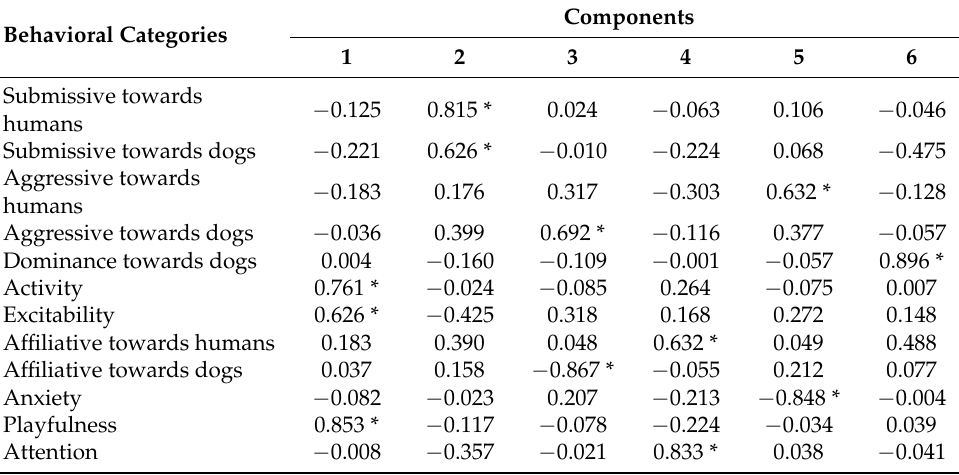
Table 3. Results from the PCA run on the difference between post- and pre-adoption data.